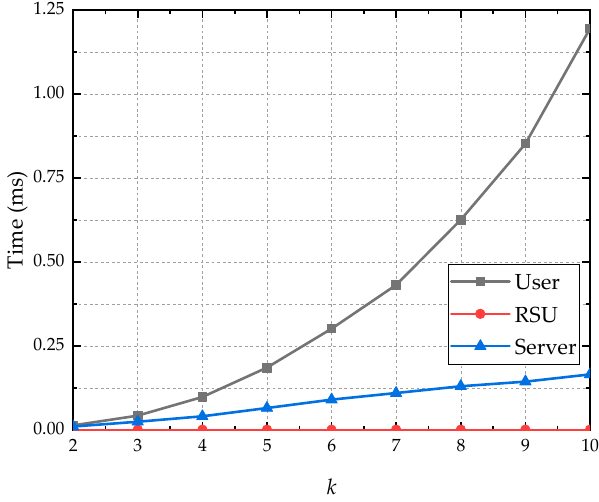
Figure 6. Impact of privacy parameter on execution time.